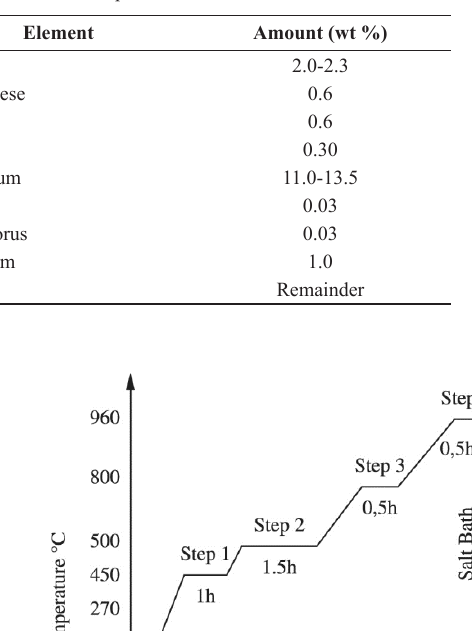
Table 1. Chemical composition of AISI D3